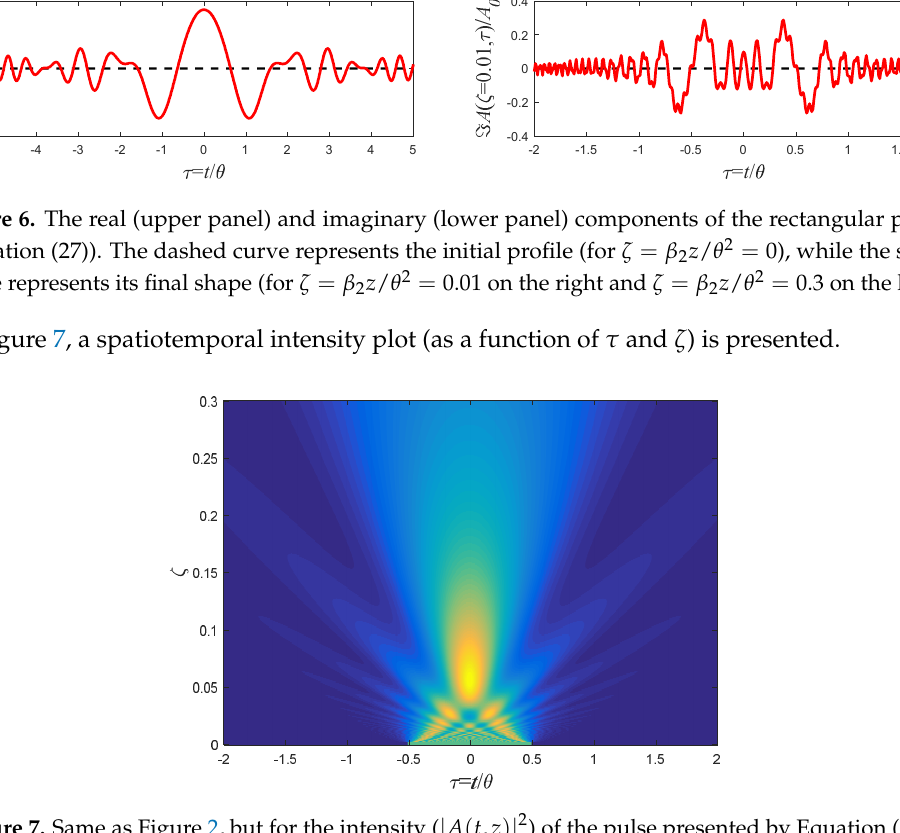
Figure 7. Same as Figure 2, but for the intensity (